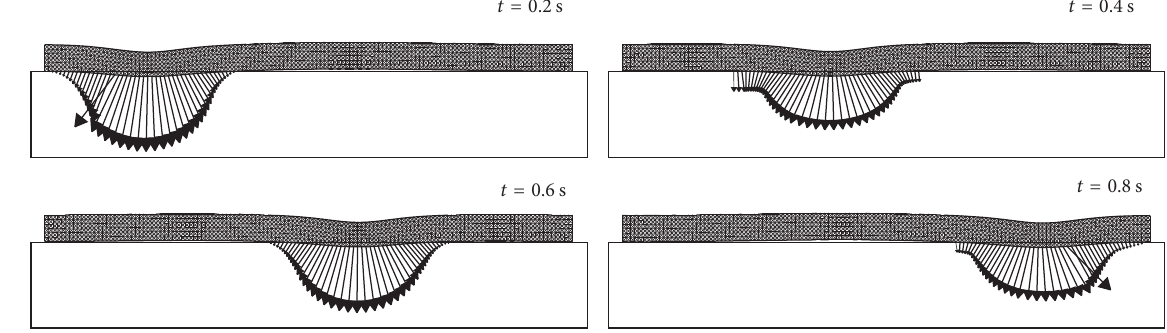
Figure 2: Time evolution of the deformed meshes and contact forces on Γ 3 .